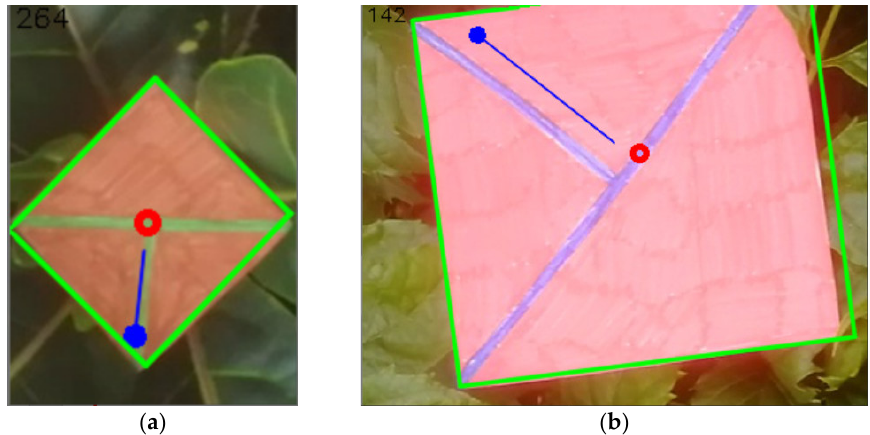
Figure 29. ( a ) the resulting image after getting information of the position (red circle), orientation (blue orientated line, the angle also being written in the left top corner of the image), and size (green outline). ( b ) the same set of information but for a different image.